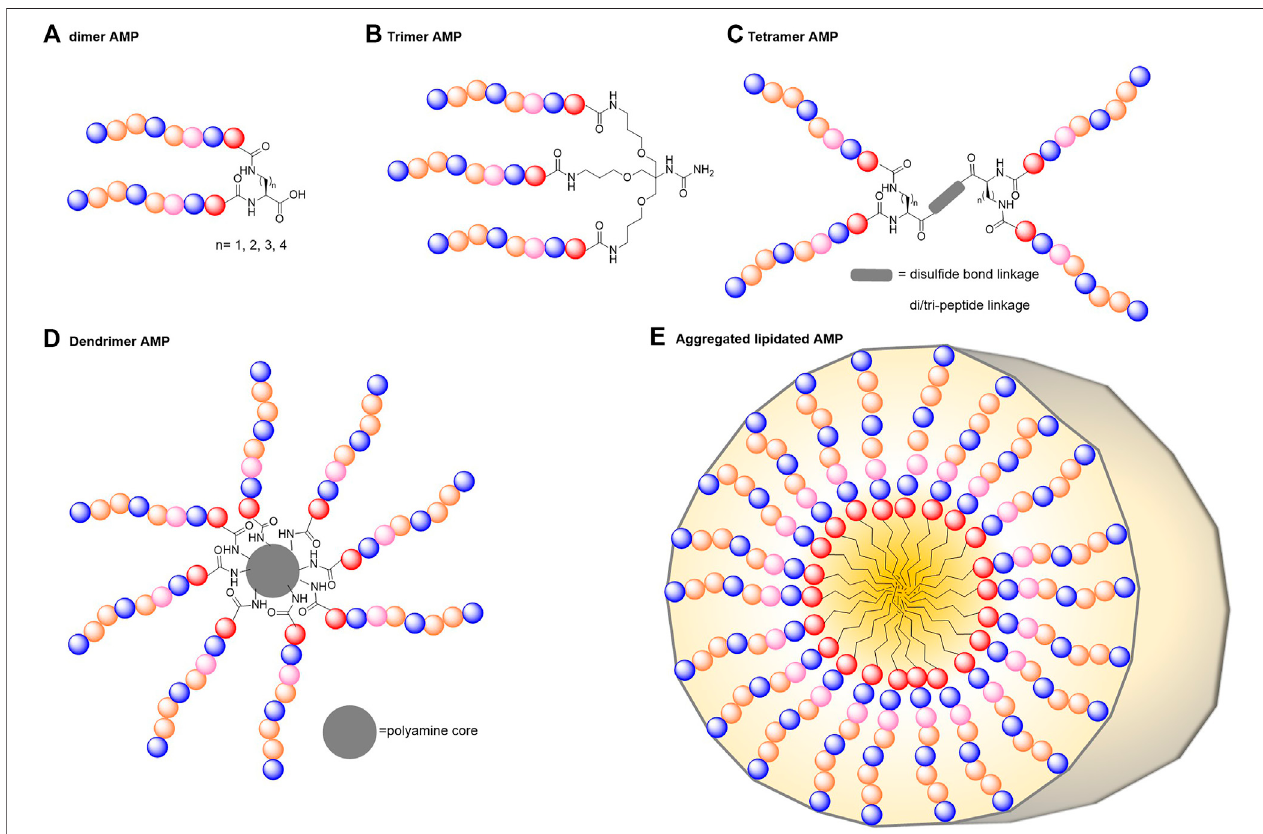
FIGURE 3 | Possible architectures of multimerised peptides. AMPs can be multimerised into various forms to improve their activity and biocompatibility. These include dimers (A) , trimers (B) , tetramers (C) , larger multi-armed dendrimers (D) or self-assembled peptide multimers (E) .